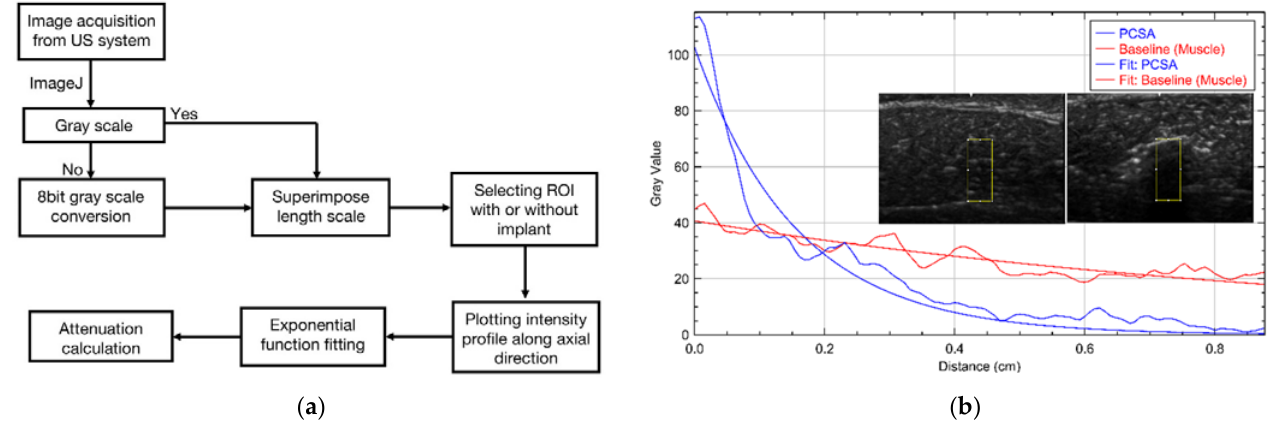
Figure 2. ( a ) Flowchart showing the attenuation analysis procedure used in this study. US images were exported to ImageJ (NIH open-source software) to scale the measurements, selecting the region of interest (ROI) and exponentially fitting the intensity profile at 6.5 MHz frequency. ( b ) Representation of exponential fit of selected ROI of two different B-mode images of baseline (left) and PCSA (right) at 6.5 MHz frequency.